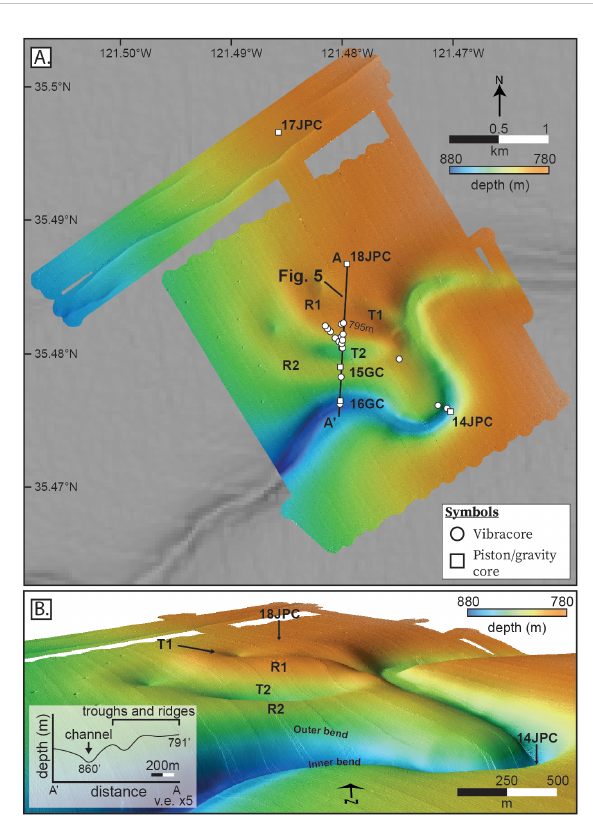
FIGURE 2 (A) Local 1m resolution bathymetric survey of the San Simeon Channel meander bend and adjacent troughs (T1 – T2) and ridges (R1 – R2). (B) Perspective view looking north (vertical exaggeration = 5x) highlighting both the meanders and the trough-and-ridge bathymetry. A-A ’ bathymetric pro fi le of trough-and-ridge bathymetry and channel (chirp pro fi le shown in Figure